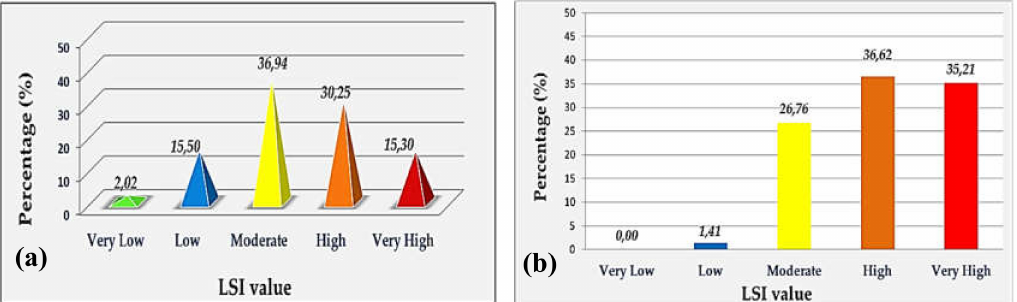
Figure 8. ( a ) The percentage of the five LSI classes in the area under study, ( b ) the percentage of the past landslides in correlation with the LSI